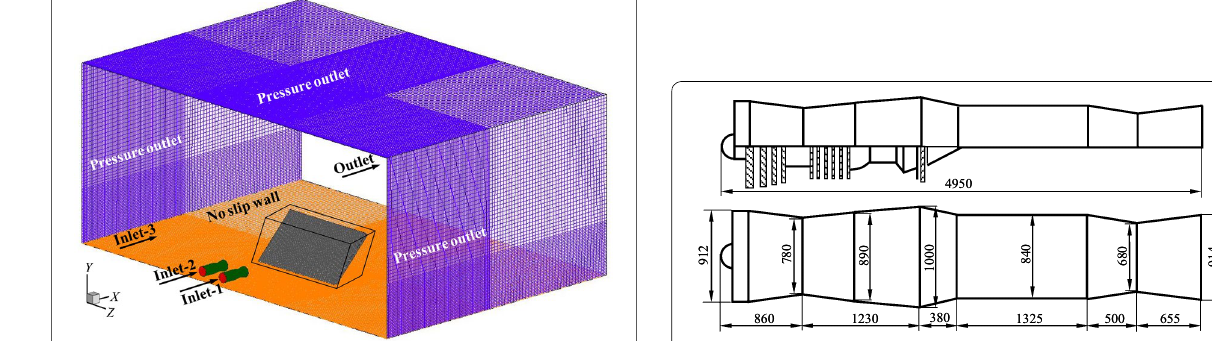
Figure 1 Computational domain of gas jet from aircraft engines Figure 2 Computational model of a single